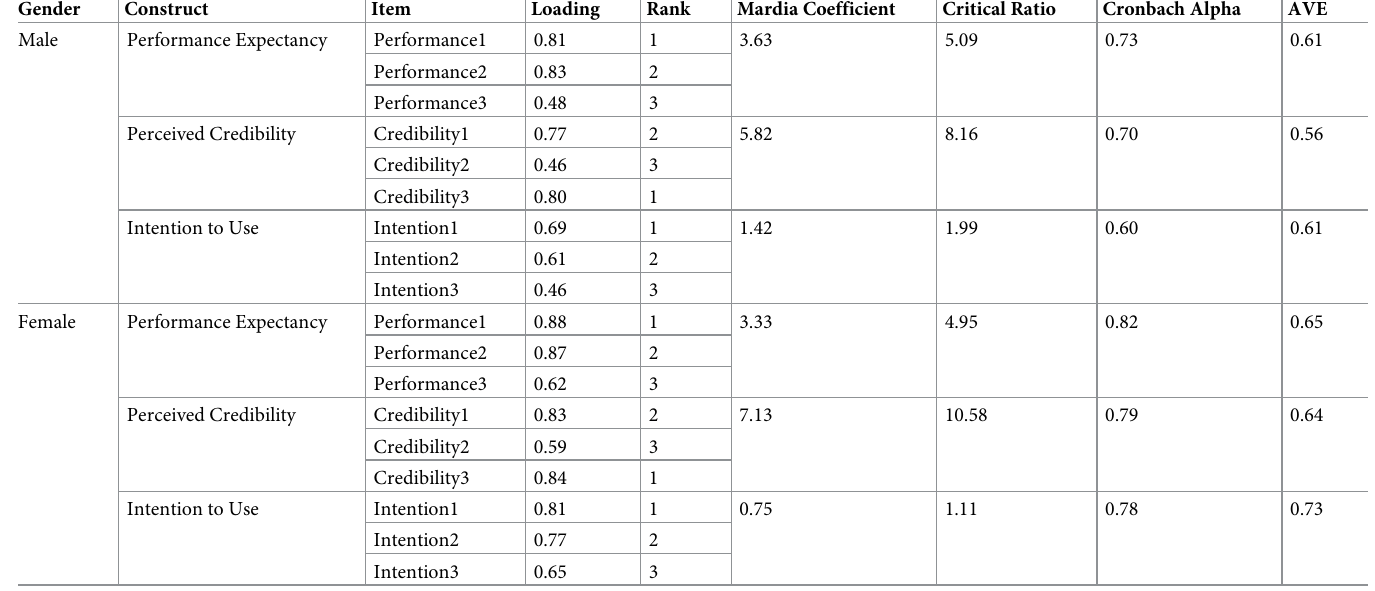
Table 3. Measurement model for male and female